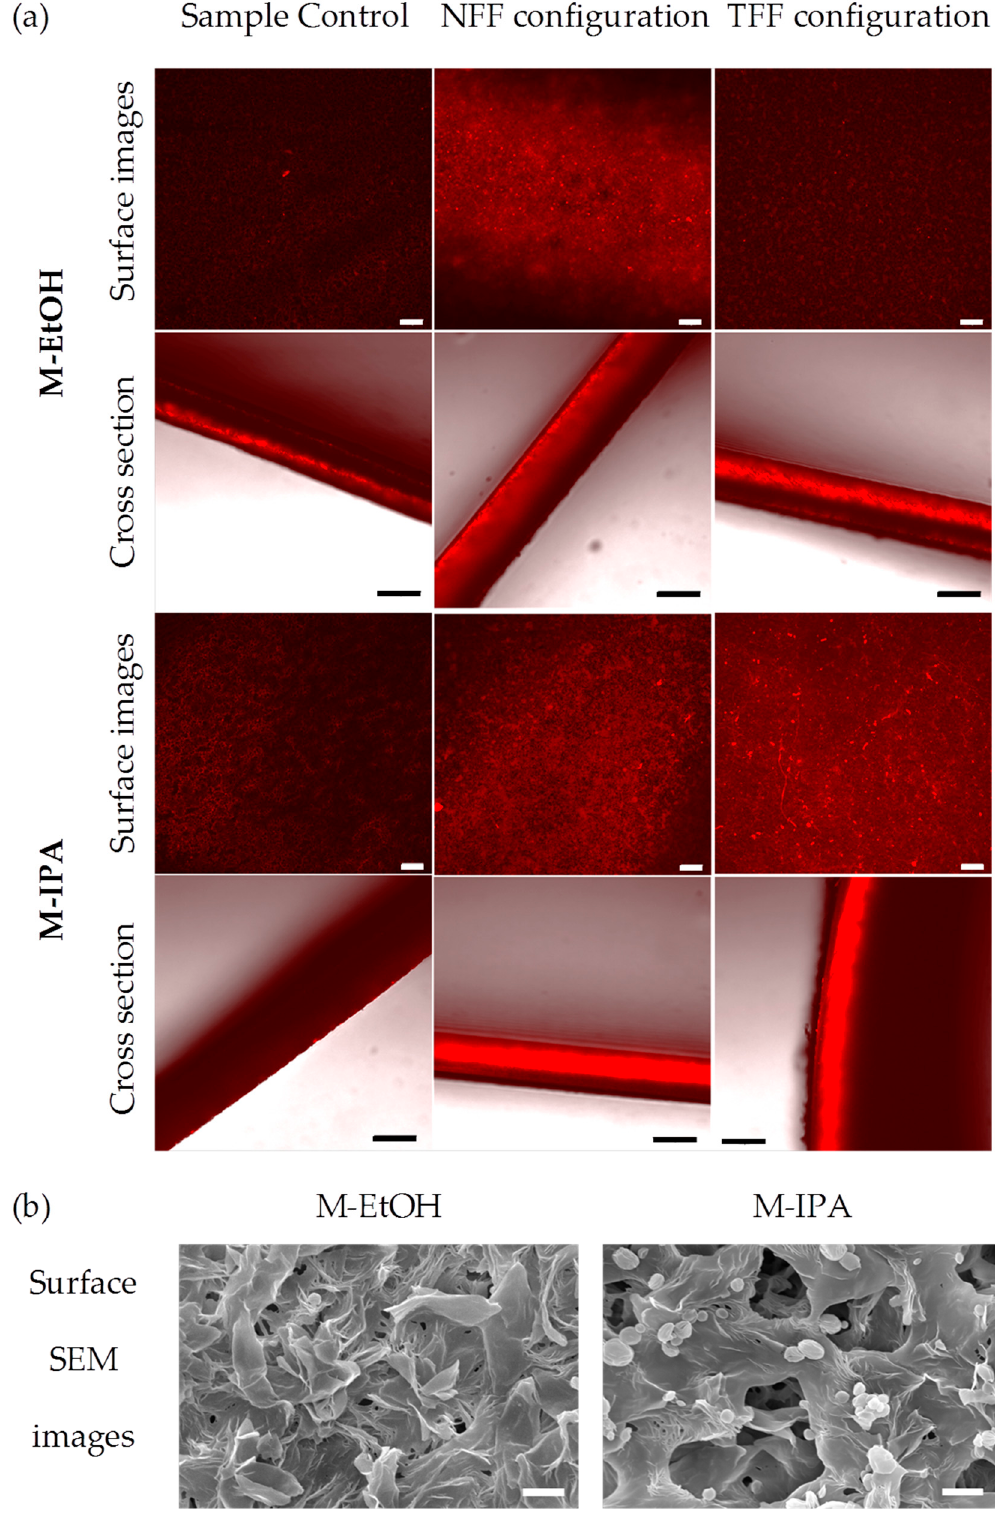
Figure 2. ( a ) Confocal of the surface (scale bar 50 µm) and cross section (scale bar 100 µm) and ( b ) surface SEM images (scale bar 3 µm) of the M-EtOH and M-IPA membranes. Red fluorescence indicates protein presence in confocal images. Confocal control images are used to evaluate the efficacy during the dye washing and any possible membrane auto fluorescence.